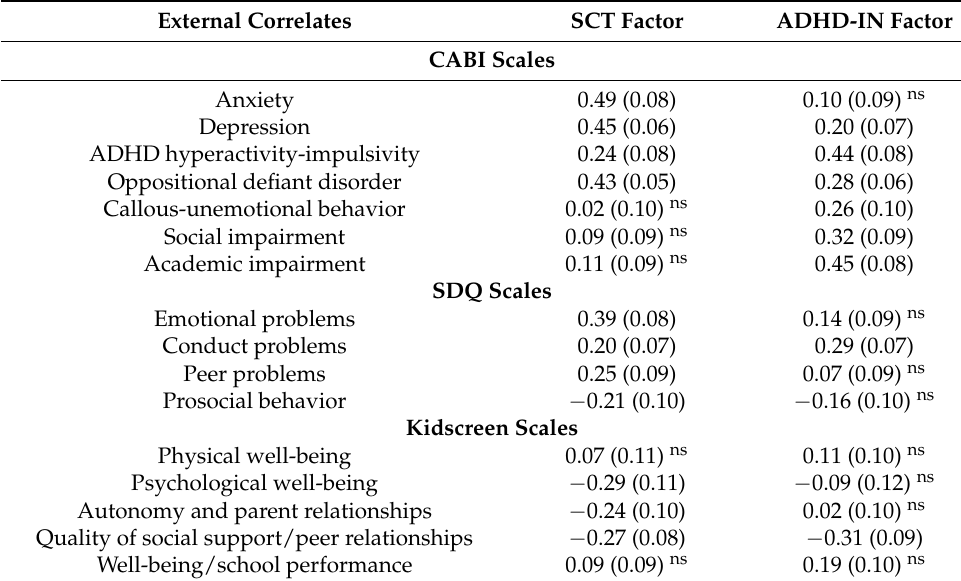
Table 3. Partial Standardized Regression Coefficients (Standard Errors) for the Association of Sluggish Cognitive Tempo (SCT) and ADHD-Inattention (IN) Factors with CABI, SDQ, and Kidscreen Scales as Manifest